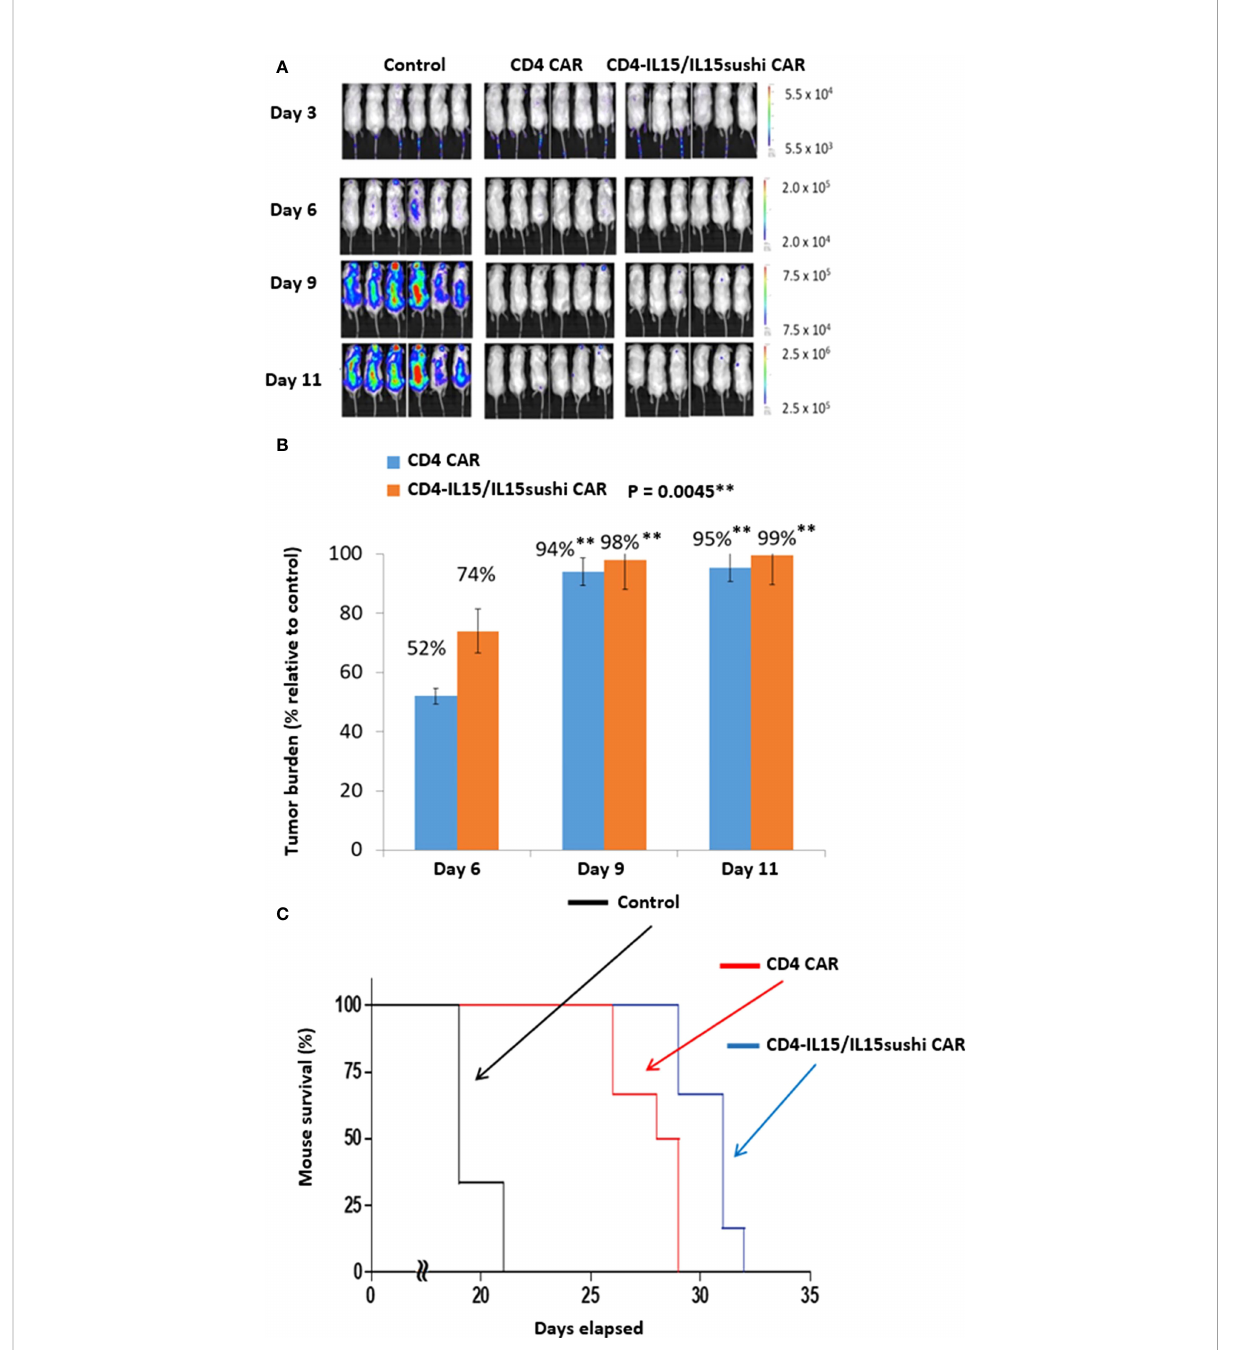
FIGURE 2 CD4 CAR and CD4-IL15/IL15sushi CAR T cells reduce tumor burden in MOLM13 mouse model. (A) NSG mice were sub-lethally irradiated and intravenously injected with 1.0x10 6 luciferase-expressing MOLM13 cells, an acute myeloid leukemia cell line that is 100% CD4+ to induce measurable tumor formation. Three days following tumor cell injection, 6 mice were intravenously injected with a course of 8x10 6 vector control, CD4 CAR, or CD4-IL15/IL15sushi CAR T cells. On days 3, 6, 9, and 11, mice were injected subcutaneously with RediJect D-luciferin and subjected to IVIS imaging to measure tumor burden. (B) Average light intensity (photons/sec) measured for CD4 CAR and CD4-IL15/IL15sushi was compared to that of control to determine the percentage of tumor burden in treated versus control mice. By Day 6, CD4 CAR-treated mice had 52% lower tumor burden relative to control while CD4-IL15/IL15sushi-treated mice had 74% lower. Unpaired t-test analysis revealed a signi fi cant difference between control and two treatment groups by Day 9 (P = 0.0045). By Day 11, tumor burden was nearly 100% decreased in both CD4 CAR and CD4-IL15/IL15sushi CAR groups compared to control. (C) Mouse survival was compared across the groups. Log-rank analysis revealed a signi fi cant difference in survival of the two treatment groups compared to the control (P = 0.0003). Additionally, the CD4- IL15/IL15sushi CAR treatment group had a signi fi cantly improved survival compared to the CD4 CAR treatment group (P = 0.0087). ** means a p-value =< 0.01, also called "very signi fi